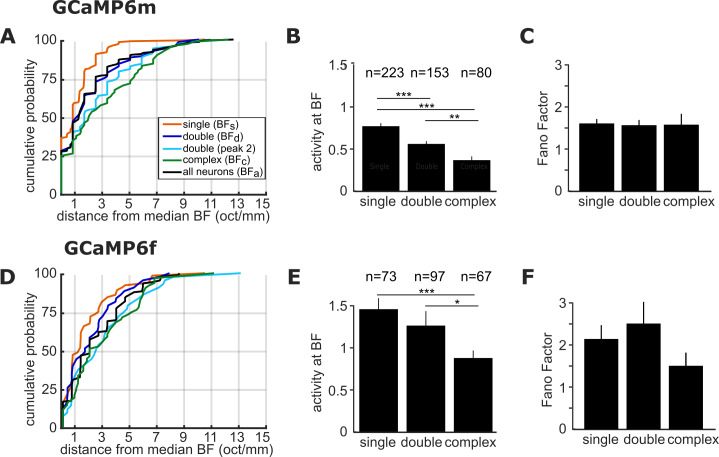
BF variance, response strength and response reliability are comparable in GCaMP6m and GCamP6f ferret datasets.Top row (A, B, C): results from imaging experiments using GCaMP6m as calcium indicator. Bottom row (D, E, F): same analyses as in A, B, C above, but using data from GCaMP6f experiments. (A, D) Cumulative probability plots of the difference (in octaves) between each neuron’s BF and the median BF of all neurons of the same FRA class in the same imaging field. Distributions for different FRA classes are plotted separately as colored lines, as in Figure 2C (see legend in A). (B, E) Magnitude of the trial-averaged response at BF and best level, calculated from deconvolved fluorescence traces. Responses were averaged across all neurons in each FRA class, and pooled across imaging fields and ferrets (mean ± SEM). (C, F) Fano Factor values (mean ± SEM) for single-peaked, double-peaked, and complex neurons. The results of t-tests are indicated above the bars in (B, E) (*p < 0.05, **p < 0.01 and *** p < 0.001).